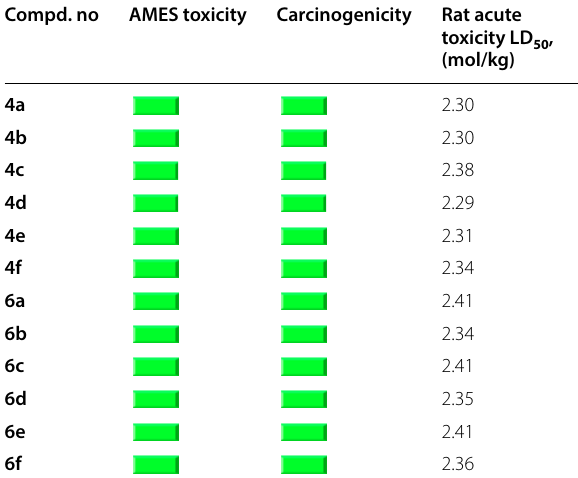
and toxicity profile 50